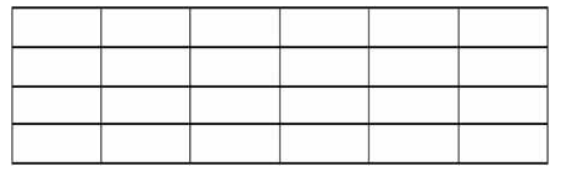
Fig. 12. Initial shape with coarse mesh of the simply supported beam.